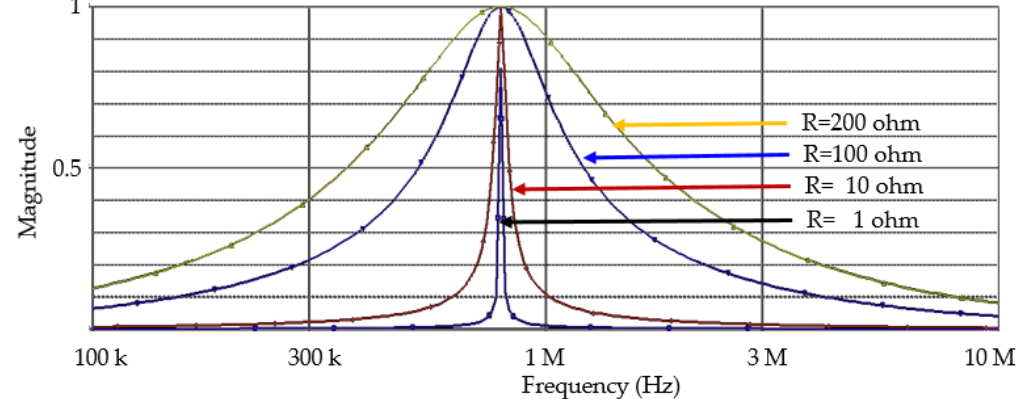
Figure 11. Quality factor of the serial resonant circuit according to resistances.